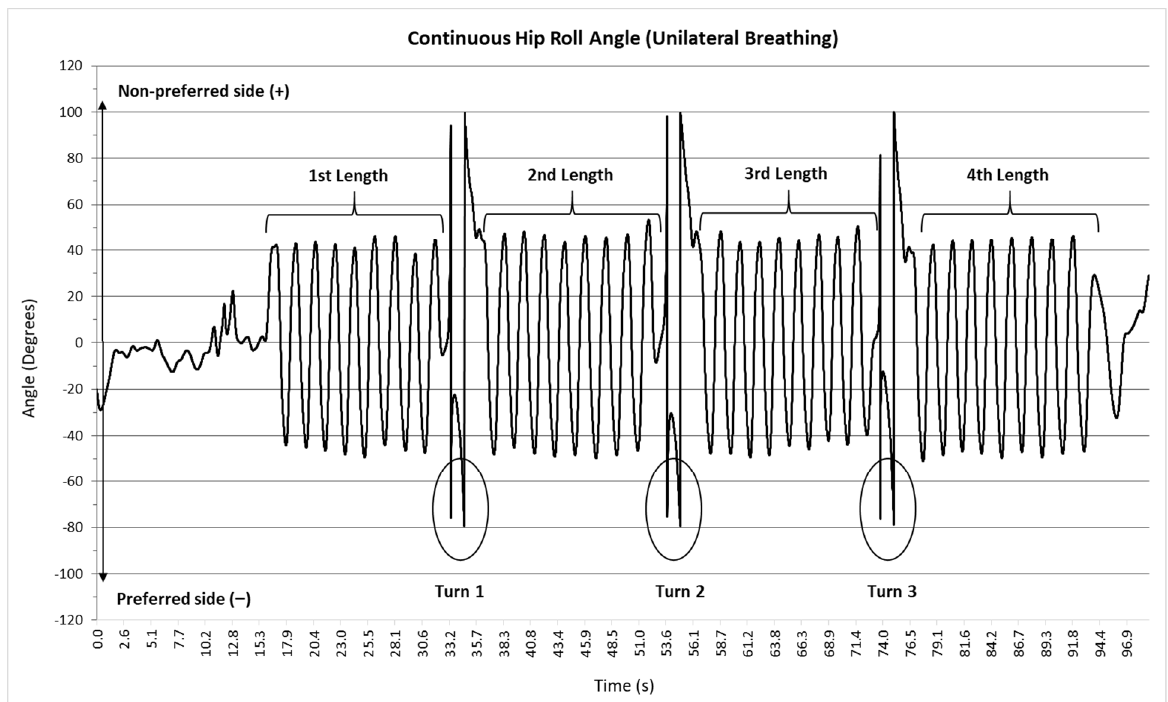
Figure 2. Representative continuous hip roll angle for each length of a 100 m unilateral (preferred side) breathing trial for a single participant.